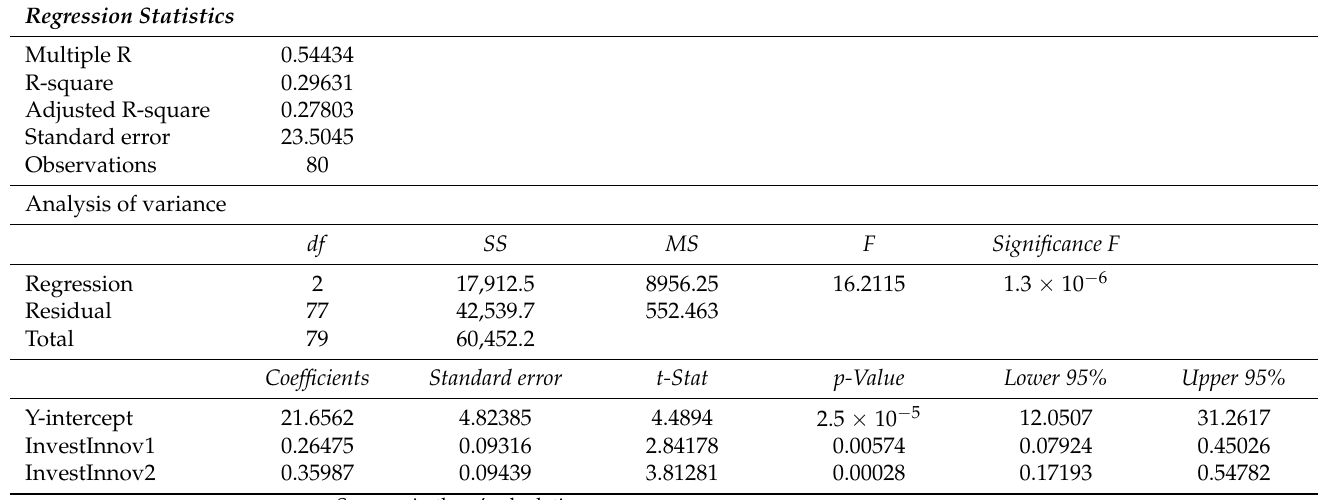
Table A5. Regression statistics of the dependence Srisk 5 on investments in innovation (InvestInnov).